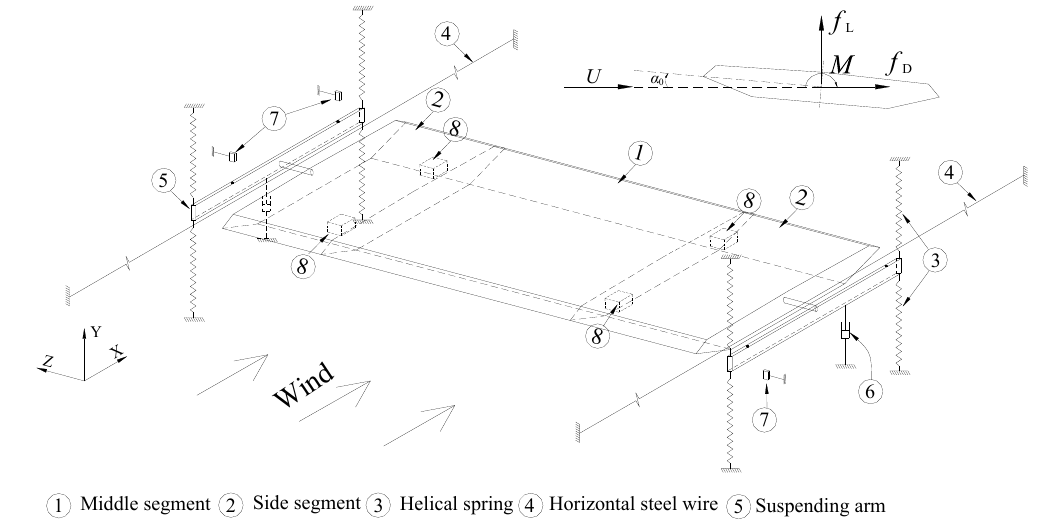
Figure 2. Schematic view and notations of the aeroelastic setup (end plates in Figure 1 not shown).